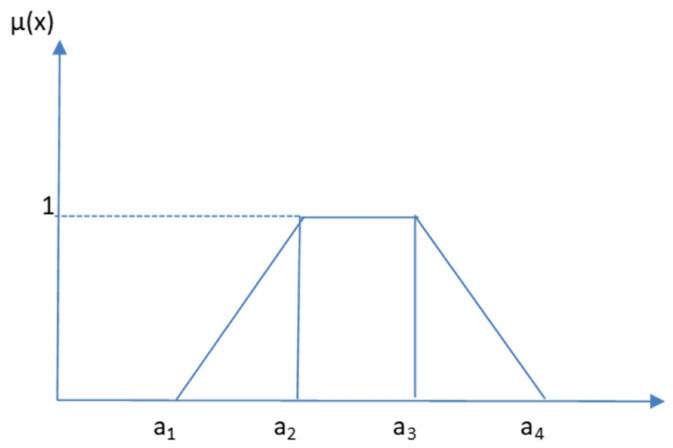
Figure 4. A fuzzy number with a continuous membership